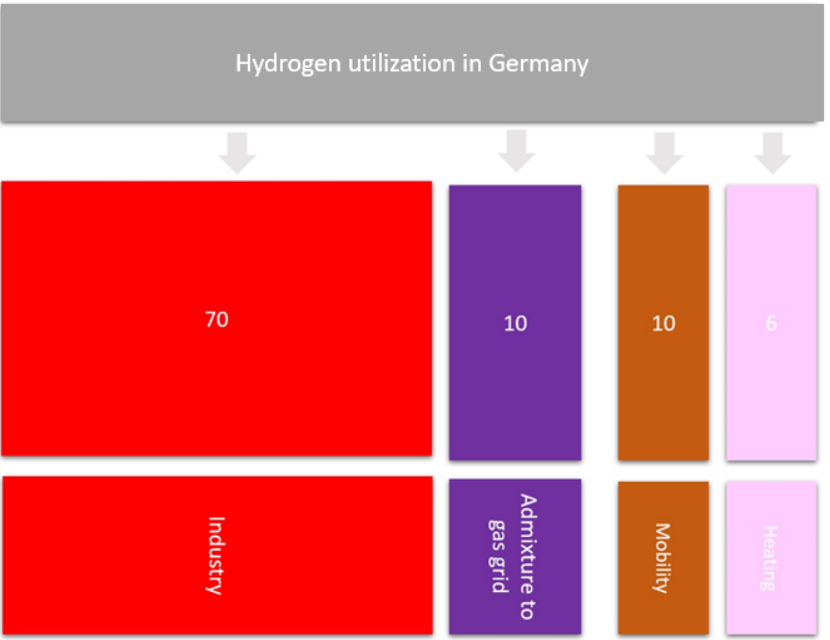
Figure 11. Hydrogen utilization in Germany (in TWh)